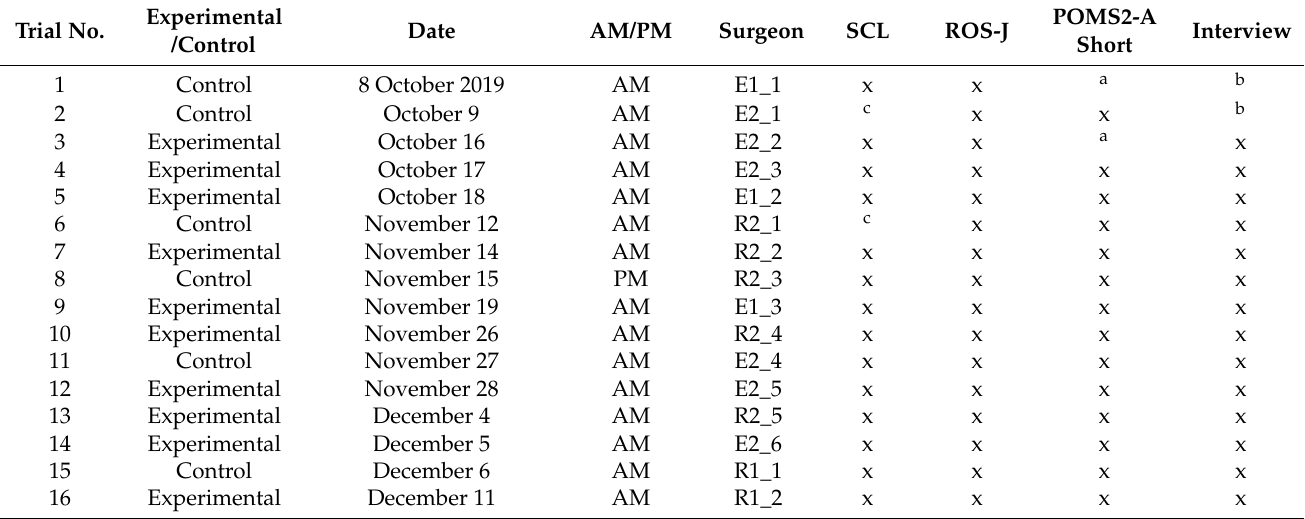
Table 1. Overview of the whole